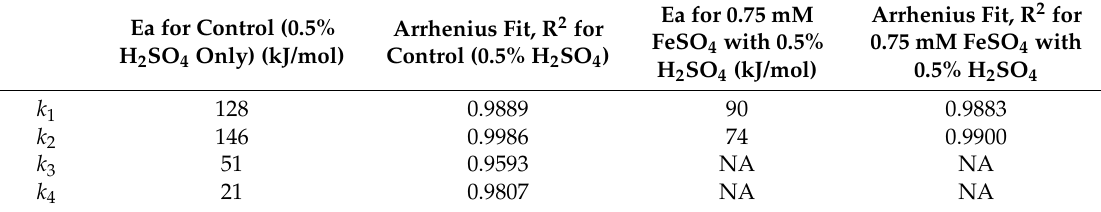
Table 3. Activation energy,